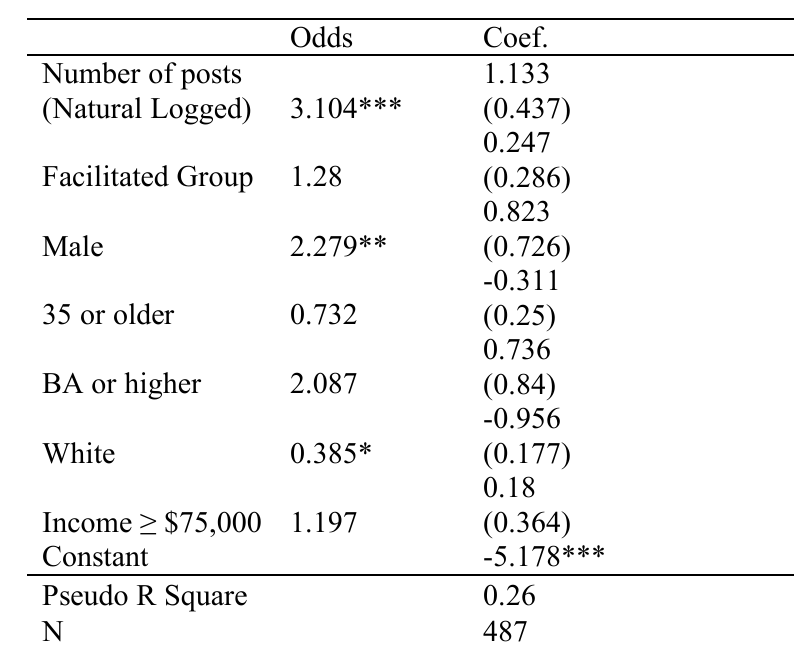
Table 1. Logistical Regression Model for Participant Posting At Least One Message Containing a